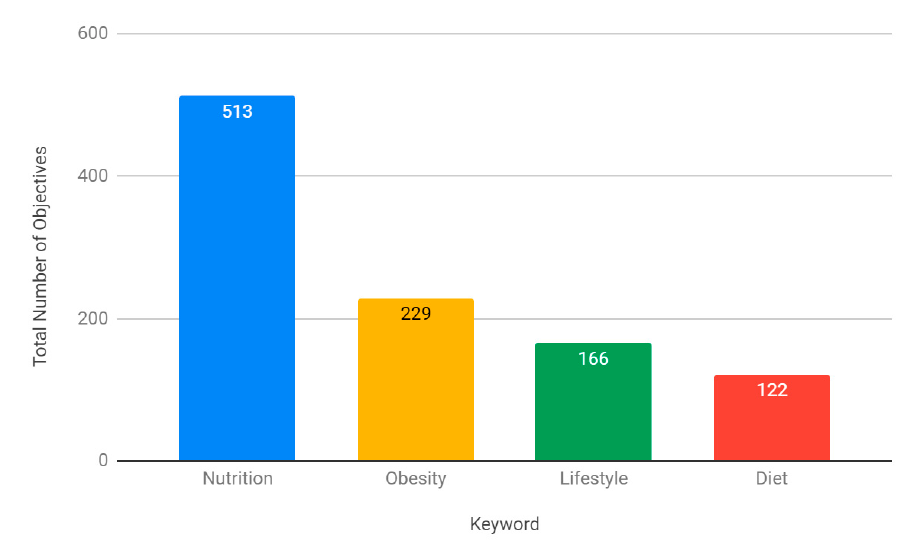
Figure 2. Total number of nutrition-related learning objectives identified per keyword across all curriculums.